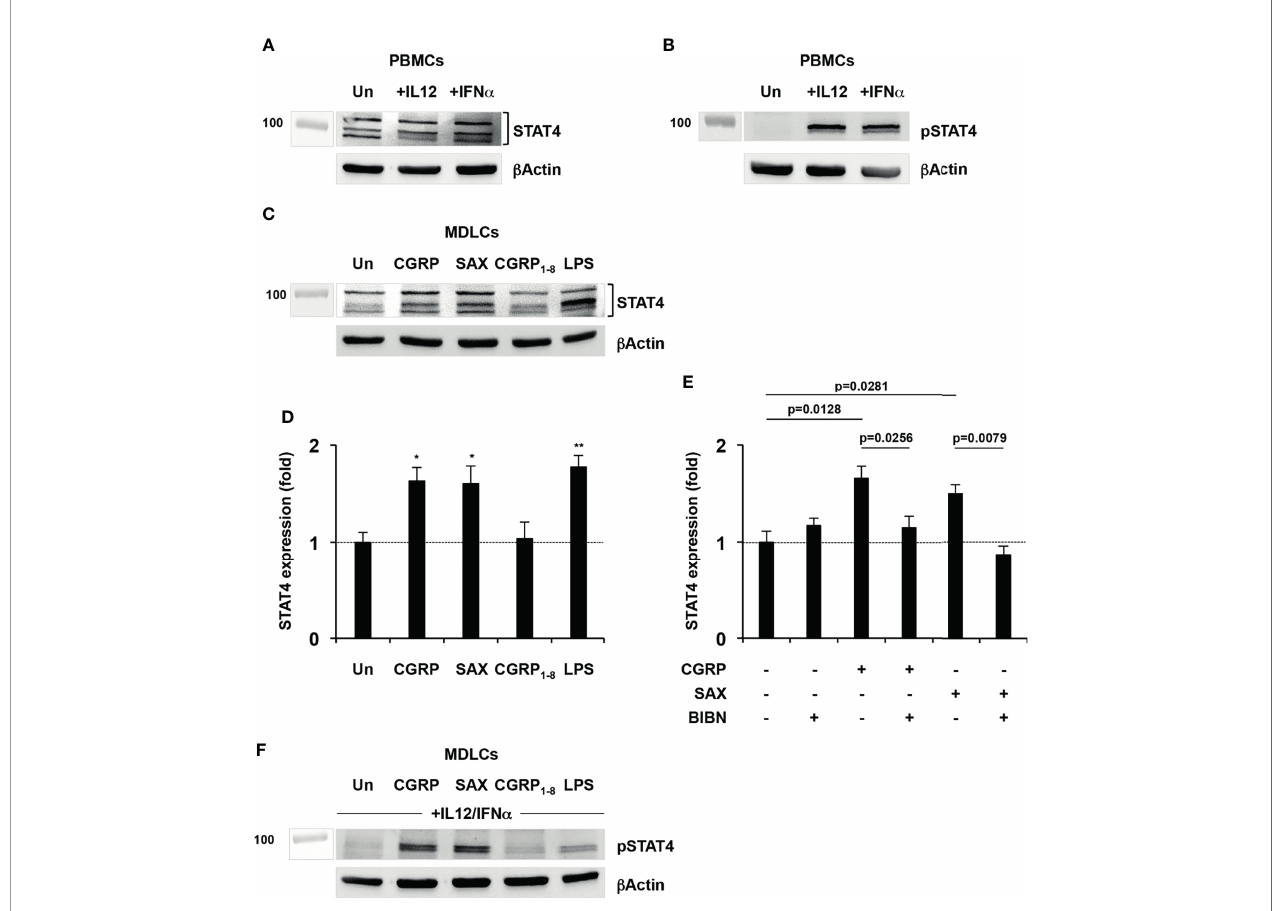
FIGURE 5 | CGRP and SAX, but not CGRP 1 – 8 , increase STAT4 expression in MDLCs. (A, B) PHA/IL2-activated PBMCs were serum-starved overnight at 37°C, and left untreated (Un) or stimulated for 30 min with either IL12 or IFN a . Shown are representative Western blots (of n = 4 independent experiments using PBMCs from different individuals) of total STAT4 (A) and pSTAT4 (B) expression. (C, D) MDLCs were cytokine-starved overnight at 37°C, and treated with CGRP (0.1 m M), SAX (0.1 m M), CGRP 1 – 8 (10 m M) or LPS (10 m g/ml) as positive control. In panel (C) , shown is a representative Western blot (of n = 4 independent experiments using MDLCs from different individuals) of total STAT4 expression. In panel (D) , shown are mean ± SEM folds expression of total STAT4, normalized to that of beta actin. *p < 0.0500, **p < 0.0050, two-sided Student ’ s t-test. (E) MDLCs were cytokine-starved overnight at 37°C and treated with CGRP (0.1 m M) or SAX (0.1 m M). The CGRP receptor antagonist BIBN4096 (BIBN, 1 m M) was added 15 min before addition of agonists. Shown are mean ± SEM (of n = 4 independent experiments using MDLCs from different individuals) folds expression of total STAT4, normalized to that of beta actin. (F) MDLCs were treated as described in panels (C, D) above, and further stimulated for 30 min with combination of IL12 + IFN a . Shown is a representative Western blot (of n = 4 independent experiments using MDLCs from different individuals) of pSTAT4